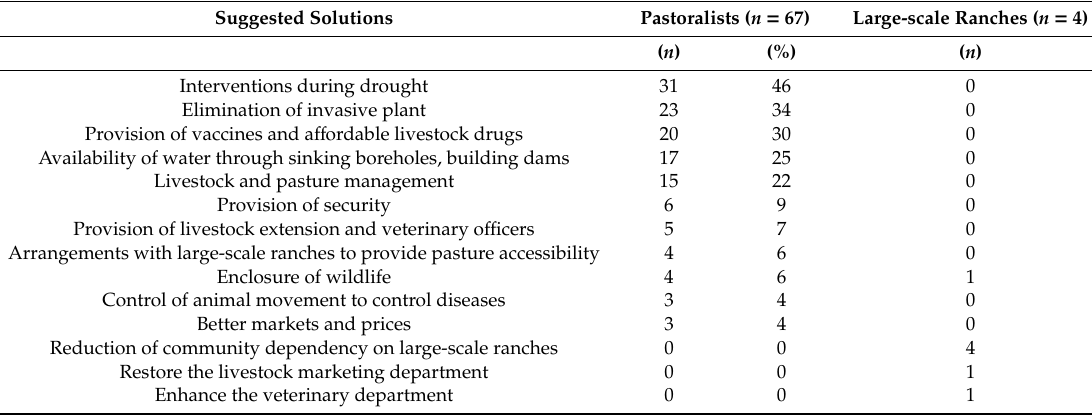
Table 4. Solutions to constraints suggested by pastoralists and large-scale